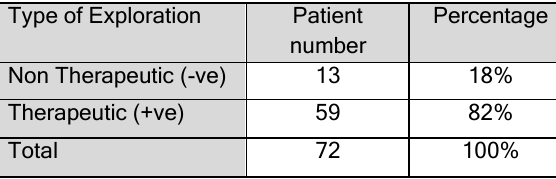
Table(6)Distribution of patient in relation to Exploration results